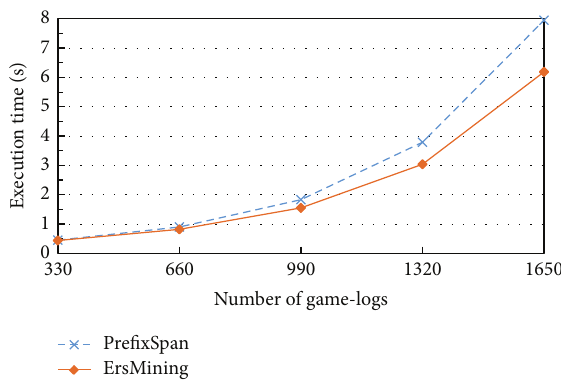
Figure 7: Performance of the two algorithms on a given data set. ErsMining denotes the set of algorithms, including Sequence- TreeCreation , BranchShifting , CBSSFinding , and ReliabilitySelection , for mining Experience Rules.